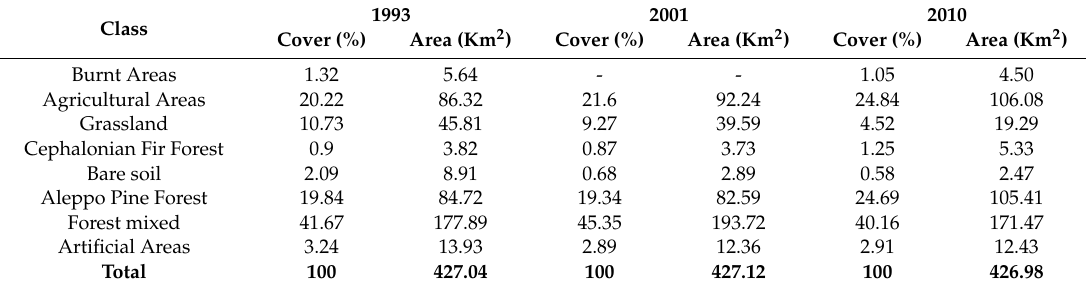
Table 4. Percentage distribution of land and land cover types per study reference